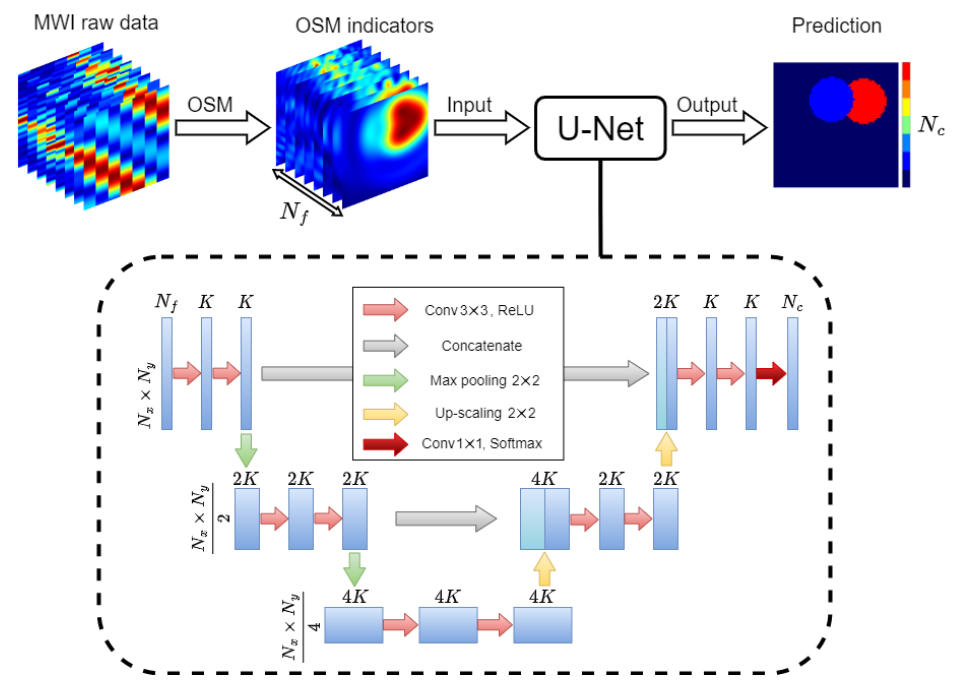
Figure 1. Flow diagram of the DL-MWI framework. The internal architecture of the U-Net with its different operations is shown inside the dashed line